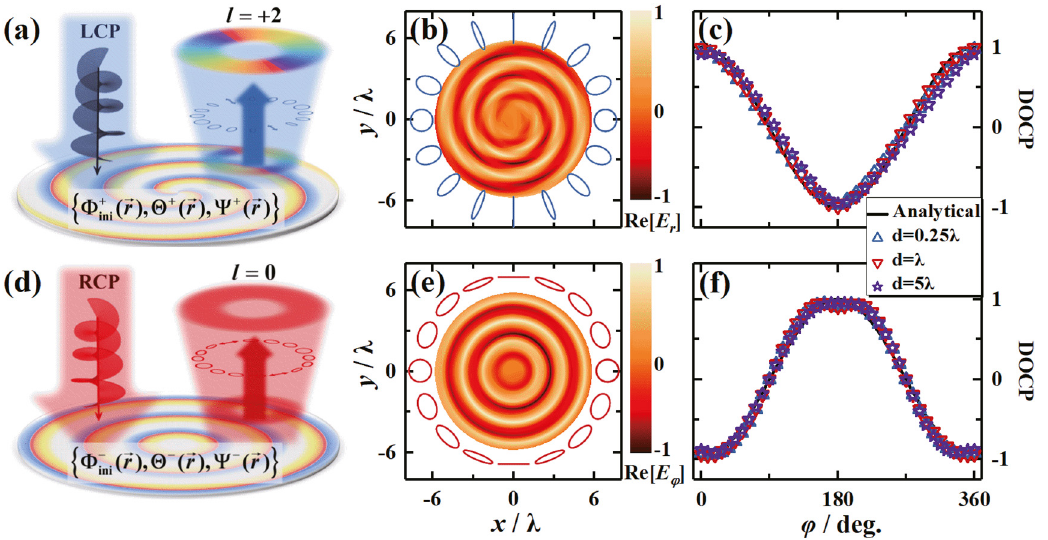
Figure 2: Analytical calculations on a model system. Schematics of light scatterings by a model metasurface exhibiting { Φ σ illuminationsof(a)leftcircularpolarization(LCP)and(d)rightcircularpolarization(RCP)incidences.(b)Re [ E r ] distributiononan xy planeat a distance d = λ above the metasurface for re fl ected beam under LCP incidence, and (e) Re [ E φ ] distribution on an xy plane at a distance d =